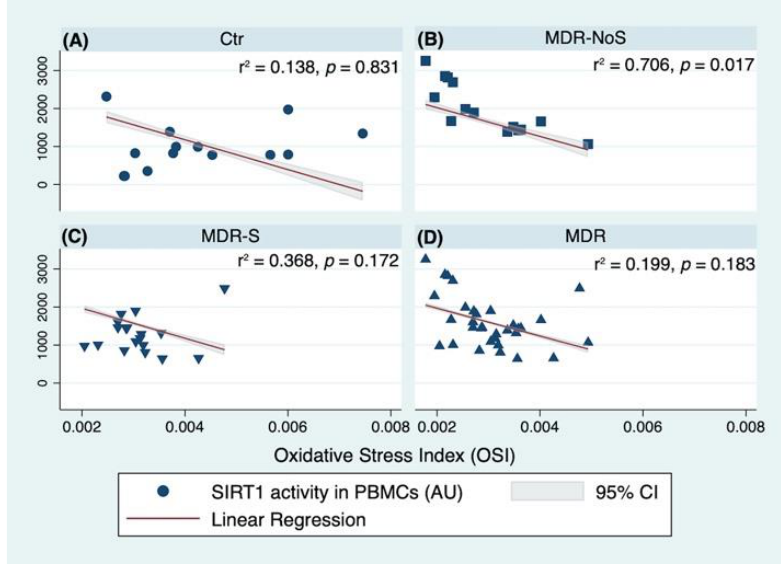
Figure 6. Linear regression analyses with SIRT1 (SIRT1) activity measured in peripheral blood mononuclear cells (PBMCs) and Oxidative Stress Index (OSI) calculated as the ratio of TOS on TEAC, CTR ( A ), MDR-NoS ( B ), MDR-S ( C ), and MDR ( D ). The groups were: sedentary controls (CTR), middle distance runners (MDR) not taking antioxidant supplements (MDR-NoS), and MDR taking antioxidant supplements (MDR-S), indicated, respectively, with a black circle, black square, black triangle with the vertex at the bottom, and black triangle with the vertex at the top. All data are expressed as mean ± SD. All data are expressed as mean ± SD.